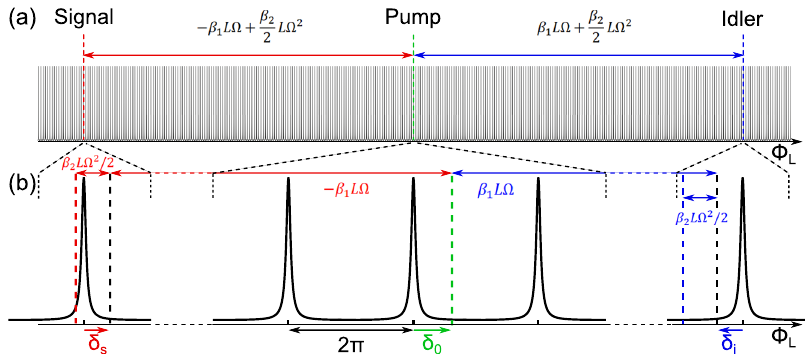
Fig. 1 Cavity resonances and pump/signal/idler locations. a Linear resonances of the cavity and cavity pumping con fi guration. b Zoom on the closest resonances from the pump, signal and idler waves. β 1 is the inverse of the group velocity, β 2 the group velocity dispersion expressed at the pump frequency, L the cavity length, Ω the pump signal pulsation shift, δ s ,0, i the signal, pump and idler detunings respectively, from the closest resonance and accumulated over one